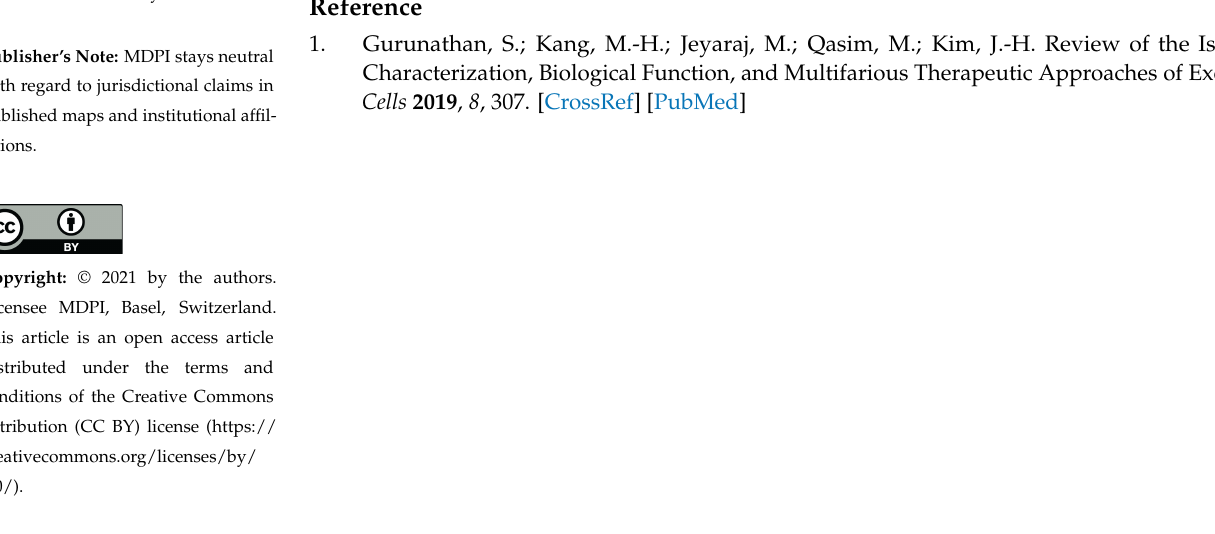
Figure 3. Silver nanoparticles induce biogenesis and secretion of exosomes in SH-SY5Y cells cultured with serum-free